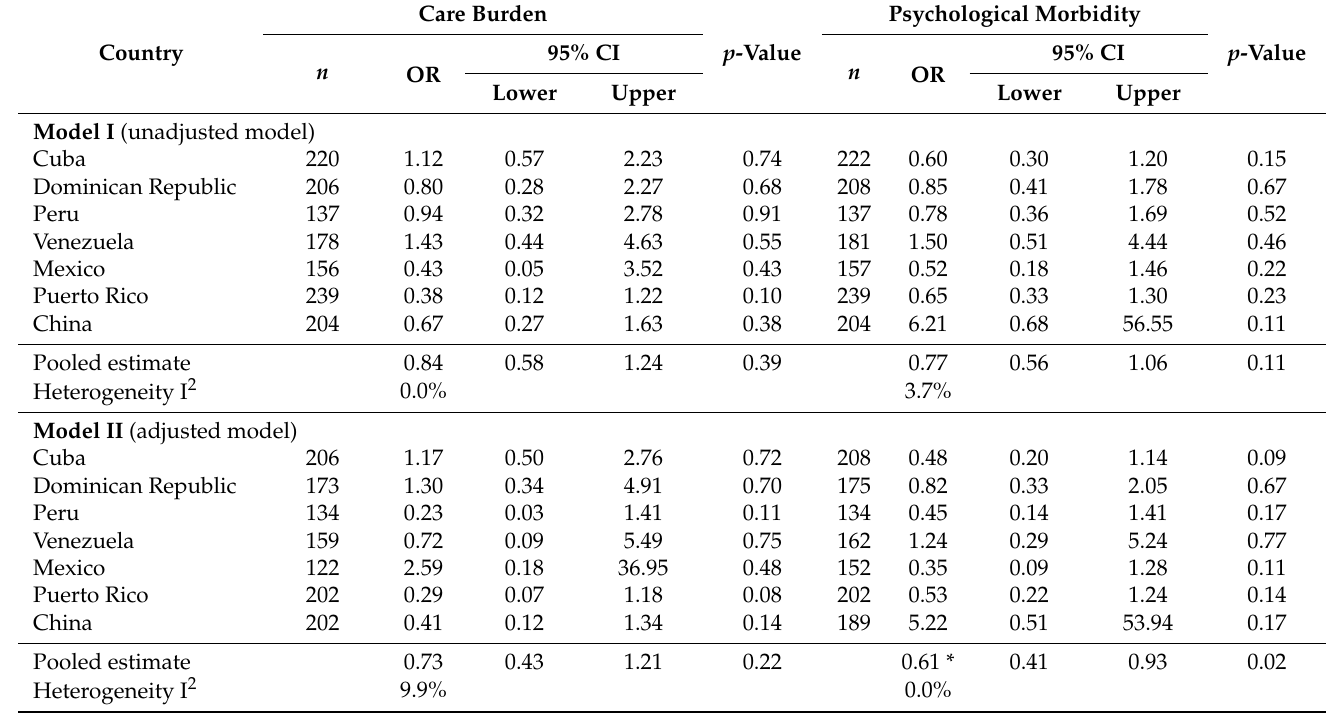
Table 3. Unadjusted and adjusted association between older caregiver and caregiver care burden and psychological